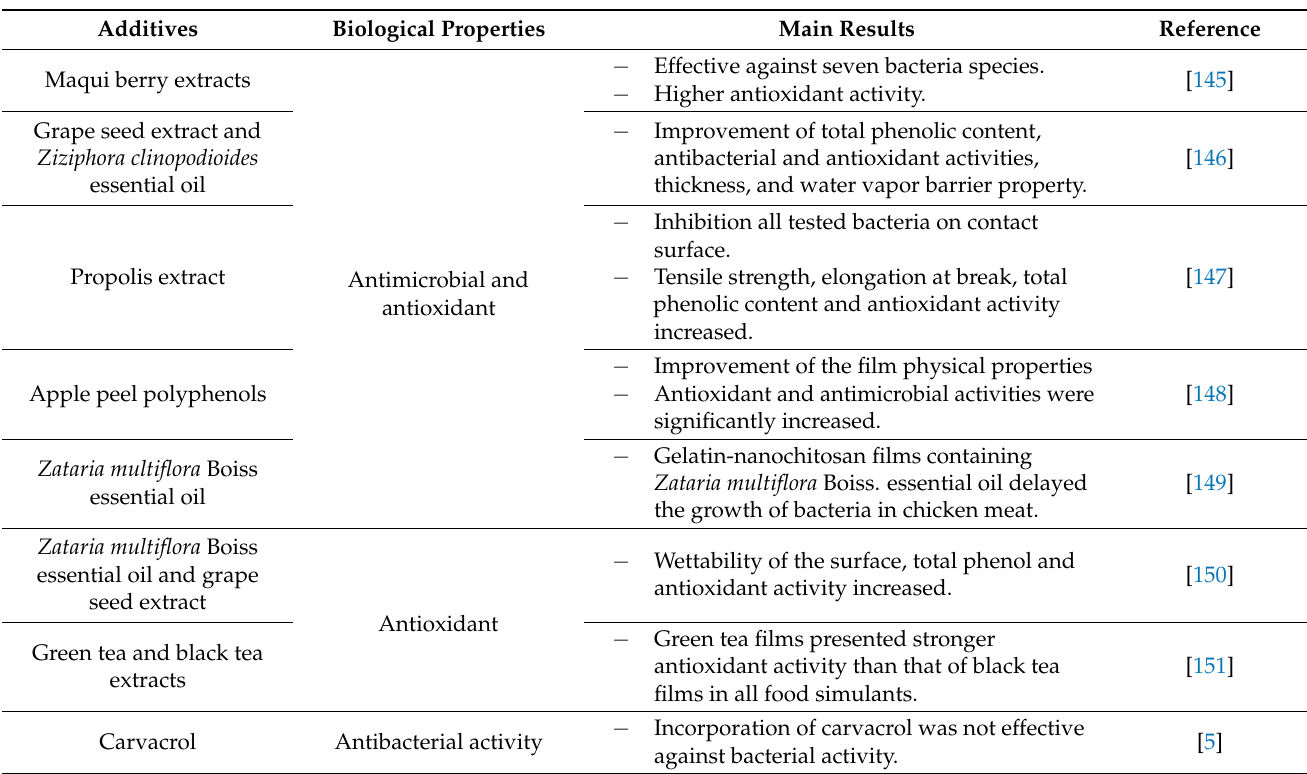
Table 4. Incorporation of bioactive substances in chitosan-based